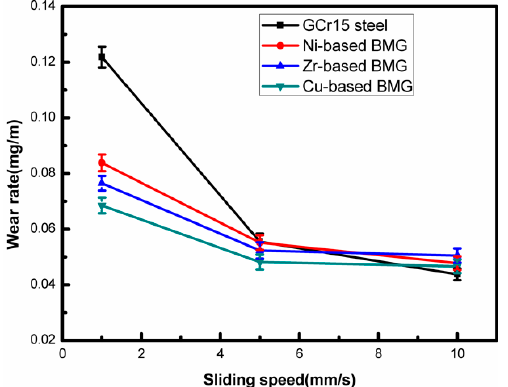
Figure 3. Wear loss of brass plates as a function of sliding speed for GCr15 steel, Ni-based, Zr-based, Cu-based BMGs counter materials under a normal load of 3 kg after a sliding distance of 60 m.